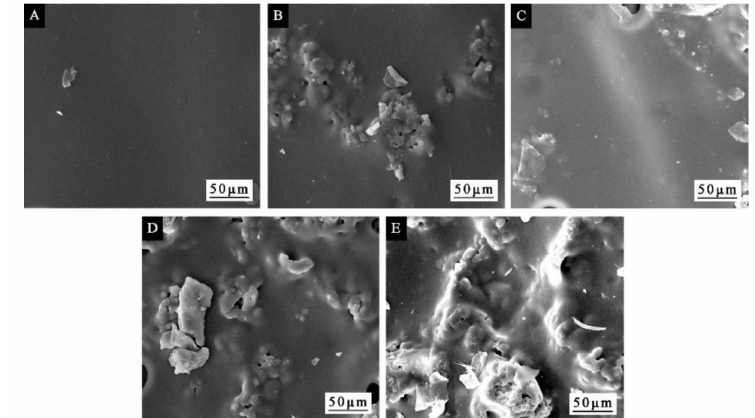
Figure 10. SEM of undamaged waterborne coatings with di ff erent concentration of microcapsule added: